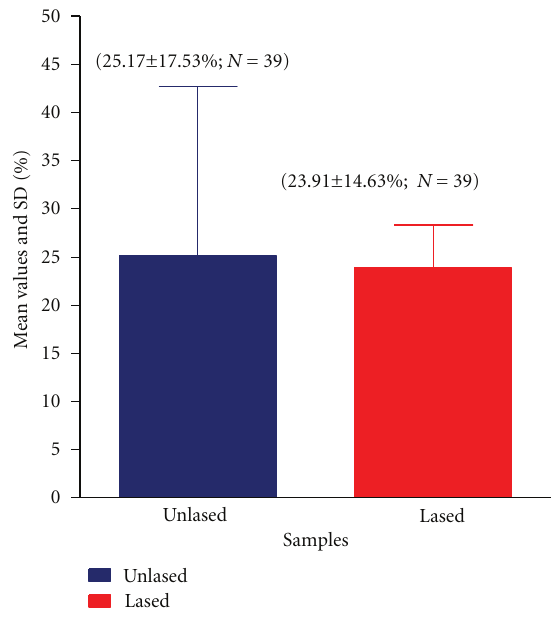
Figure 2: Mean values and standard deviation of the dye penetra- tion (microleakages) in cavities filled with MTA. Lased: mean of Dye penetration in the Er:YAG lased dentine cavities (group ML); Unlased: mean of dye penetration in the unlased dentin cavities filled with MTA (group M).